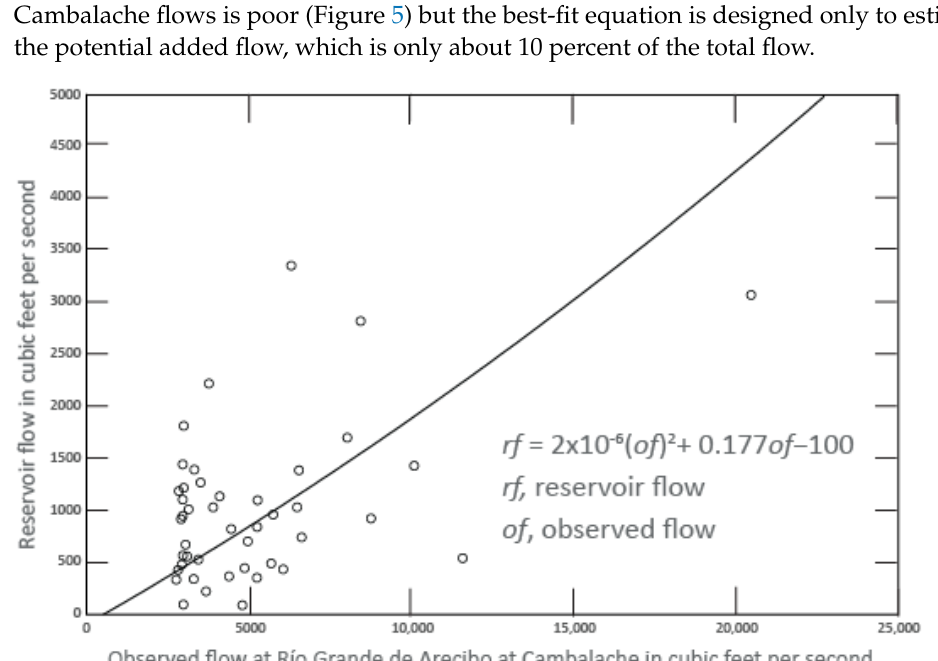
Figure 5. Regression equations for flows from Lago Dos Bocas.